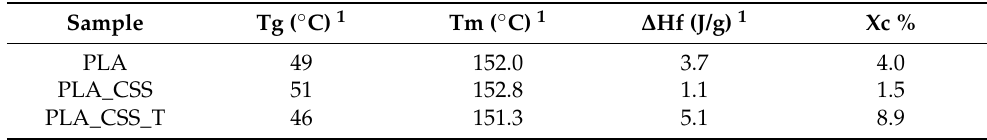
Table 2. Thermal analysis results of the investigated materials 1